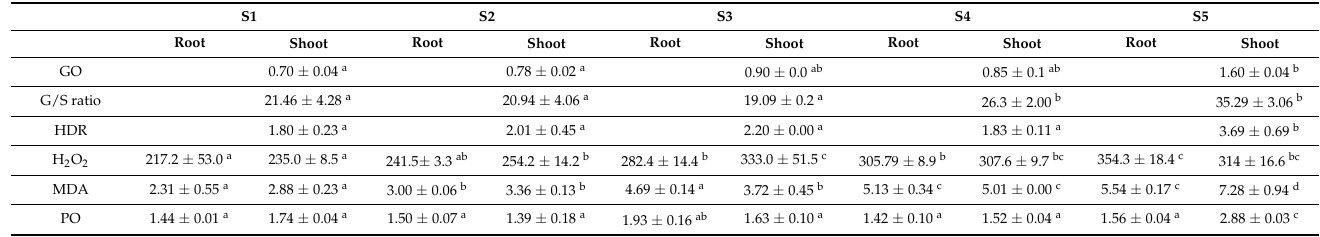
Table 6. Oxidative stress markers of S. portulacastrum grown in different control sites (Site 1) and contaminated sites (Site 2–5). Data are mean values ± SE ( n = 4). Different letters (a–d) represent the significant differences between the effect of heavy metal stress in the different target sites (Tukey test ( p < 0.05)). S1 S2 S3 S4